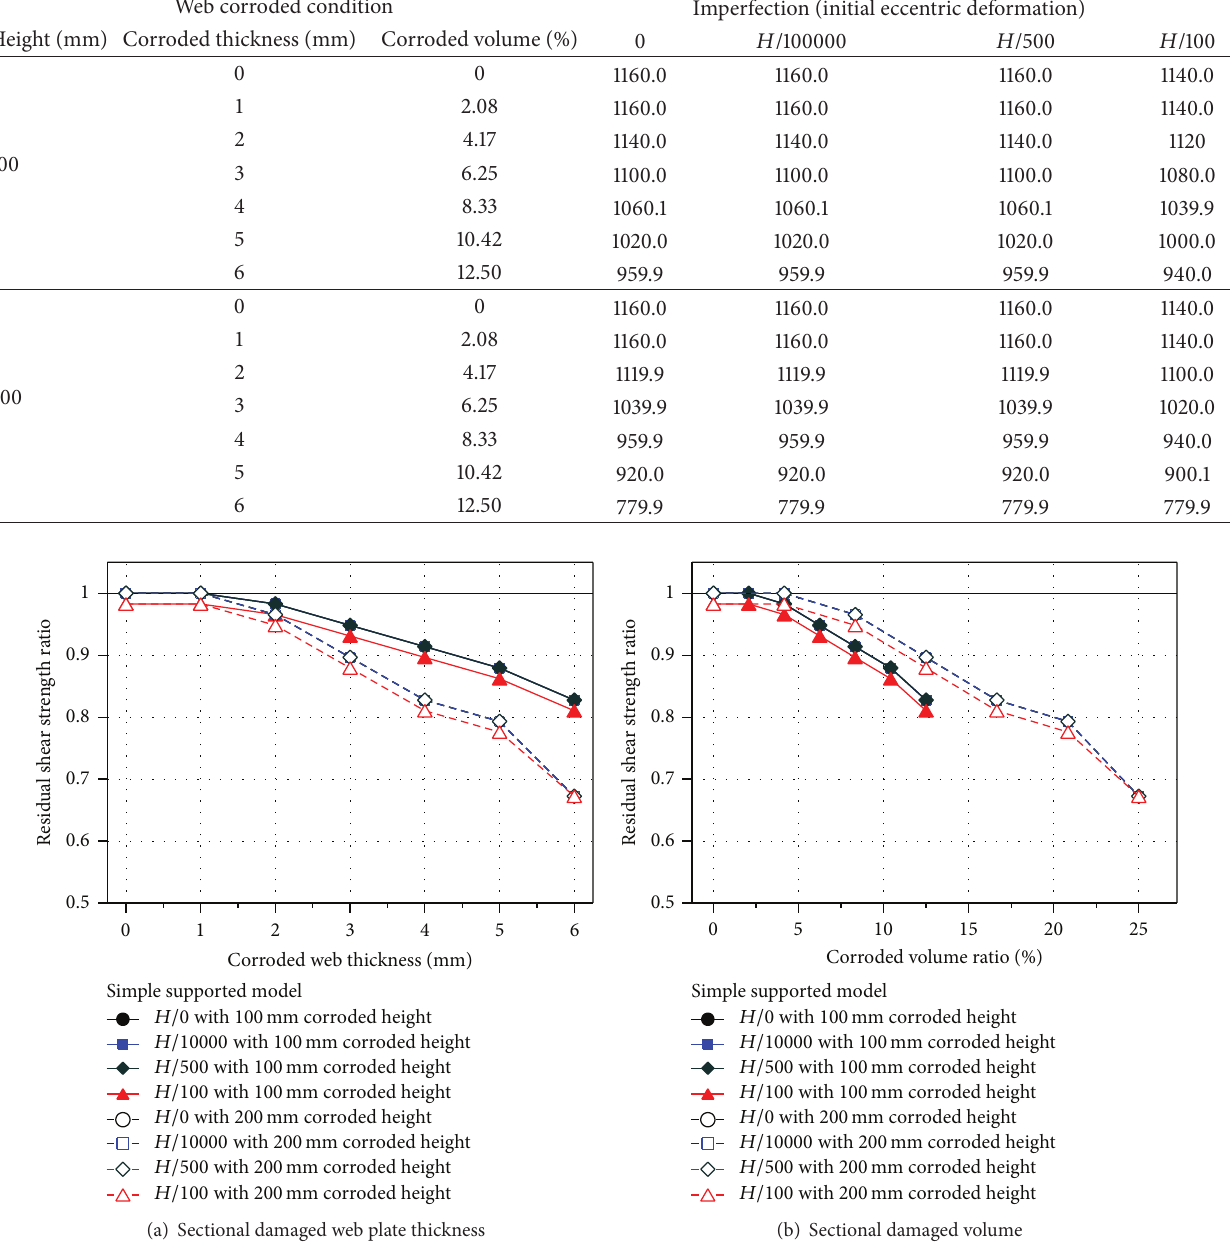
Figure 6: Shear buckling resistance ratios with roller